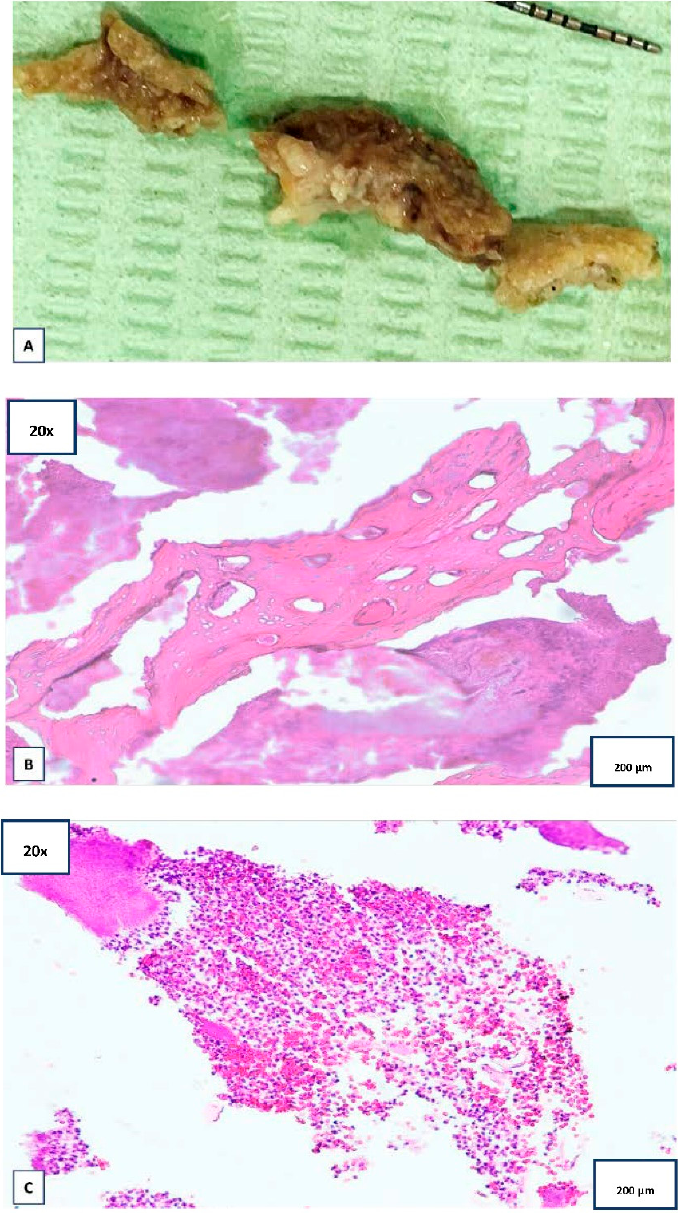
Figure 3. ( A ) Necrotic bony fragments removed from the left posterior alveolar ridge of the mandible. ( B ) A photomicrograph of a hematoxylin and eosin-stained section showing bony sequestrum surrounded by dense colonies of bacteria (20×). ( C ) A photomicrograph of a hematoxylin and eosin-stained section showing bacterial colonies surrounded by granulation tissue and abscess (20×).